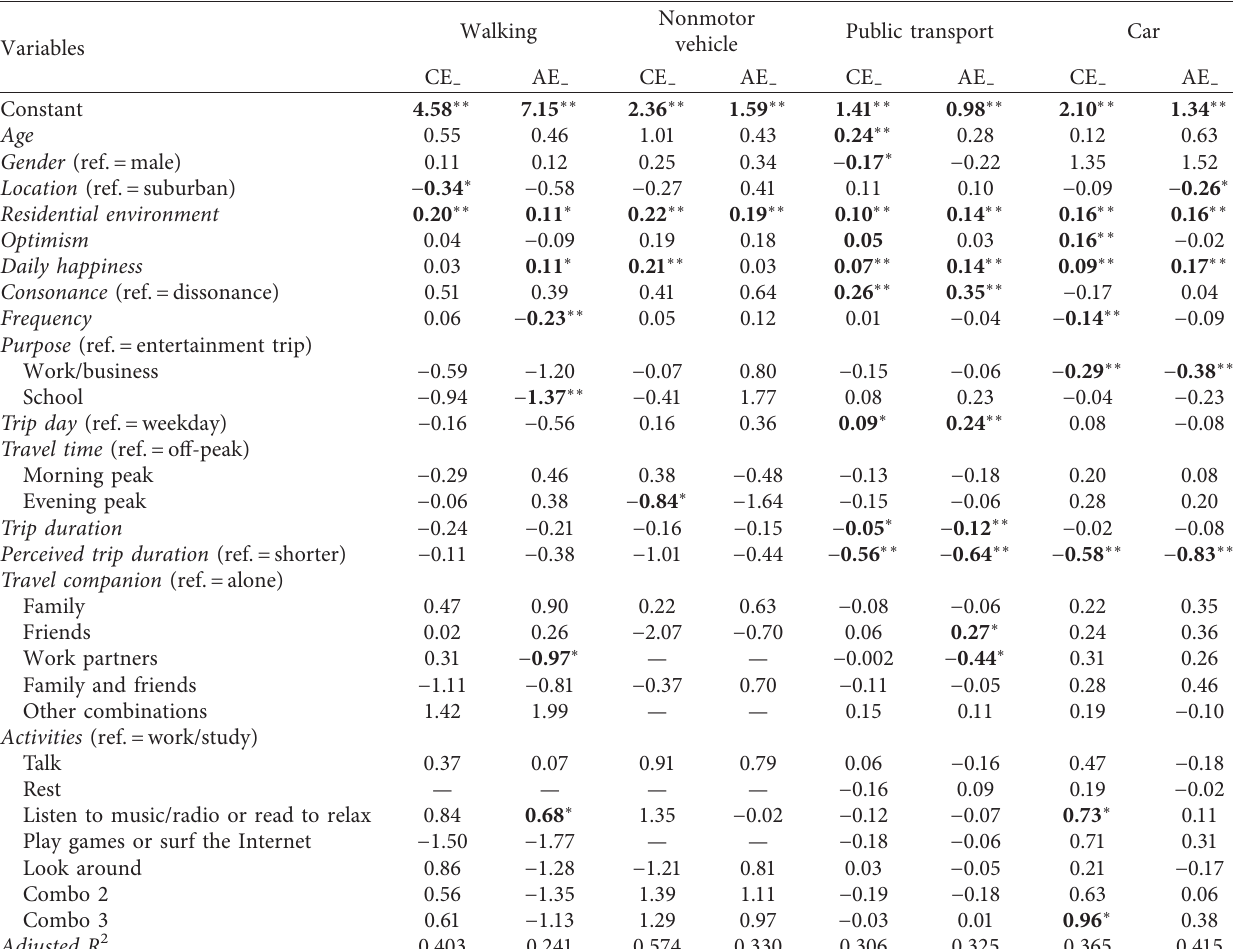
Table 5: Multiple regression results ( N �